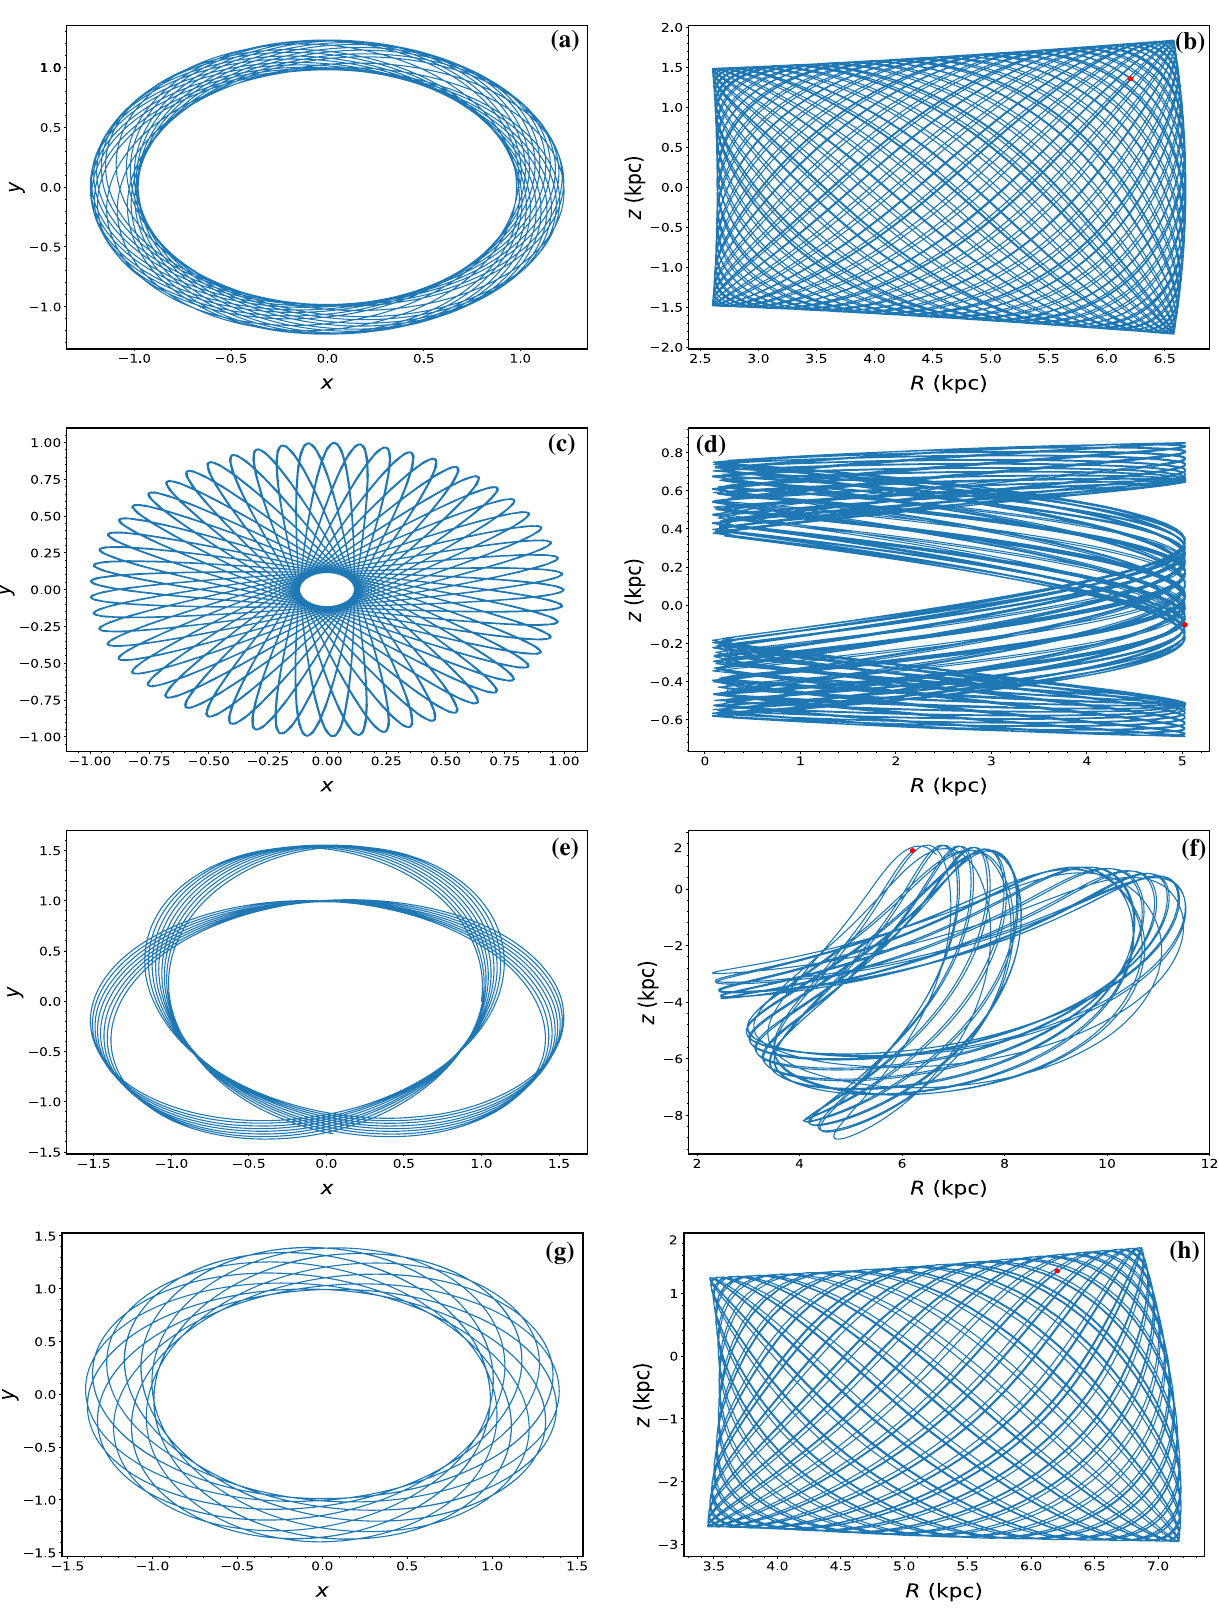
Fig. 2 Orbit collection of different types of orbits in axial symmetric galaxy model for different possible values of the parameters. The panels refer to the composition of Miyamoto-Nagai and Weyl potentials. The red dot signs the globular cluster Omega Centauri’s